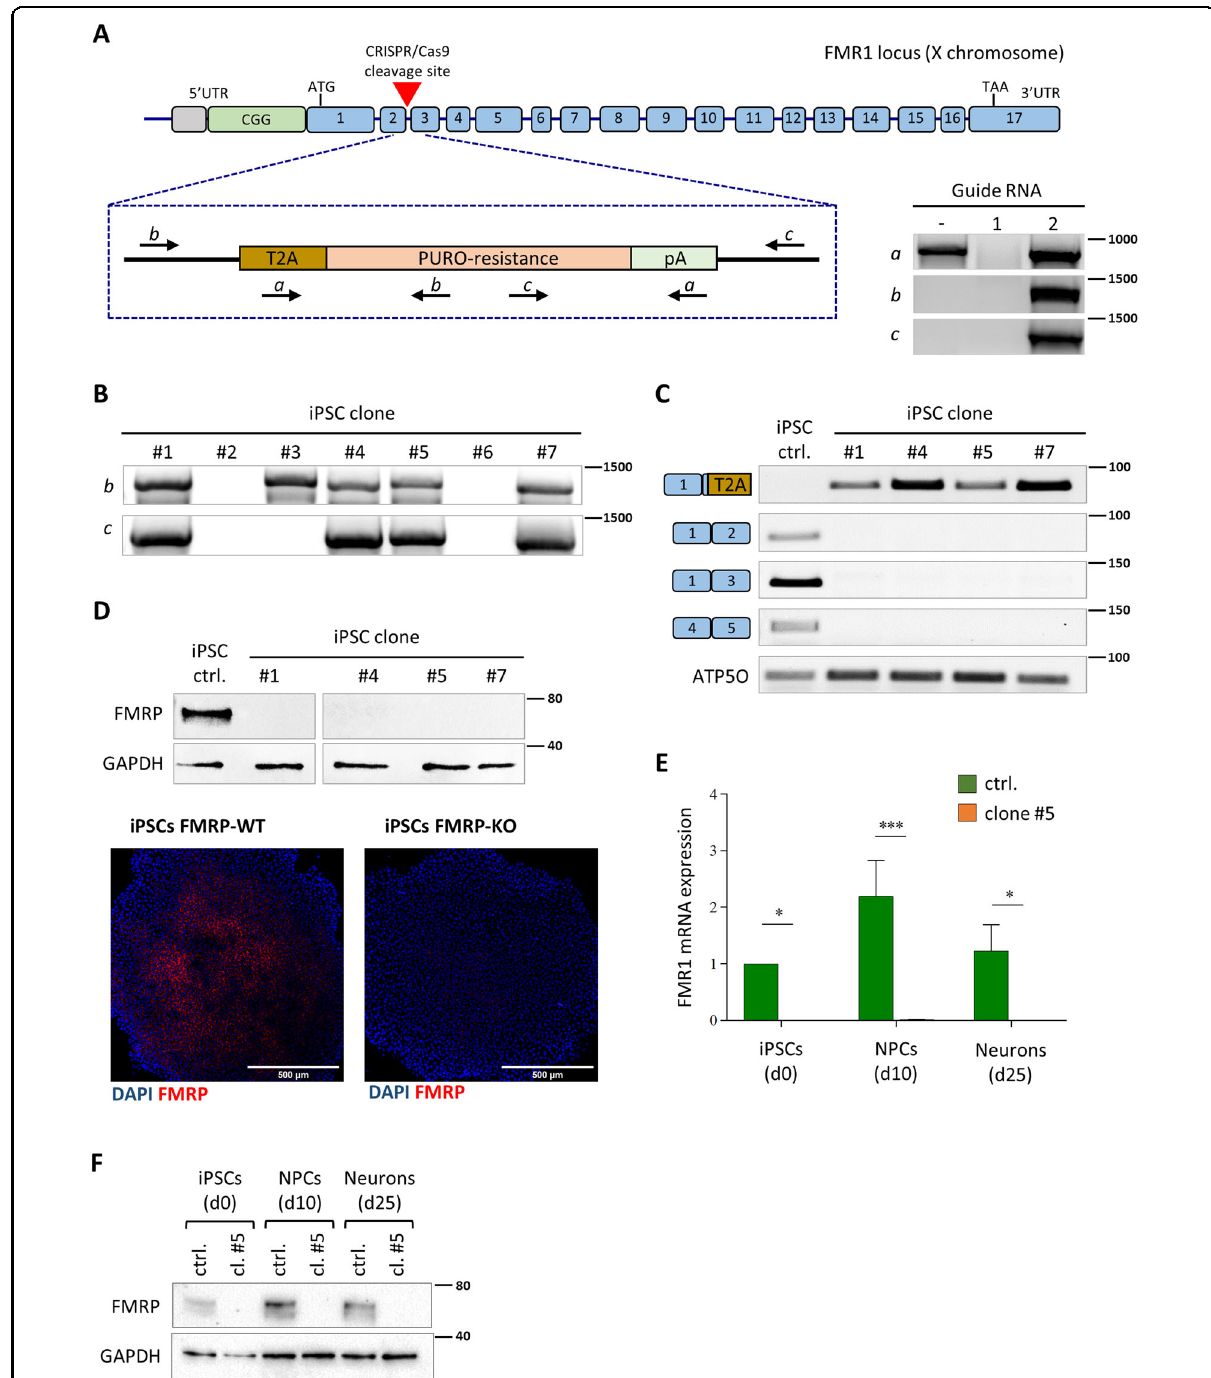
Fig. 1 (See legend on next